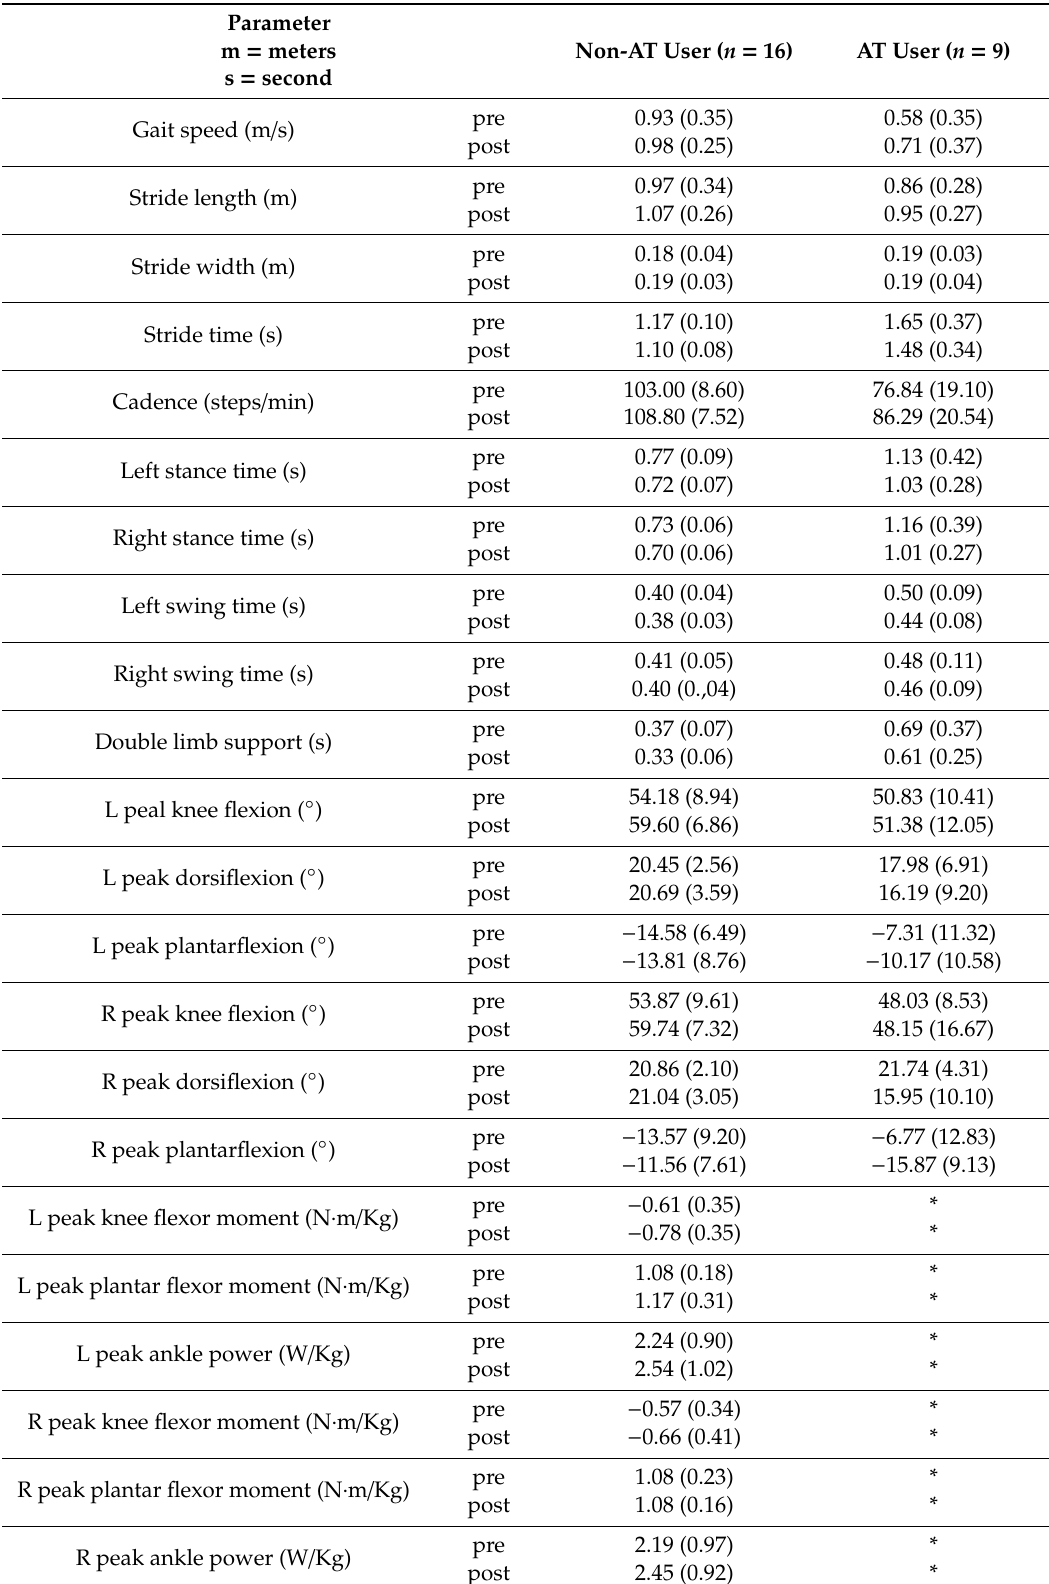
Table 4. Mean (std) in spatiotemporal and kinematic parameters for the non-AT and AT users.